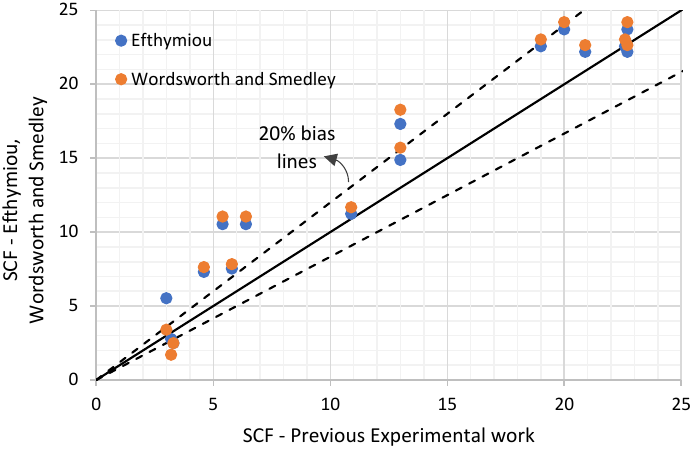
Figure 4. Existing database for DT joints under axial loading.